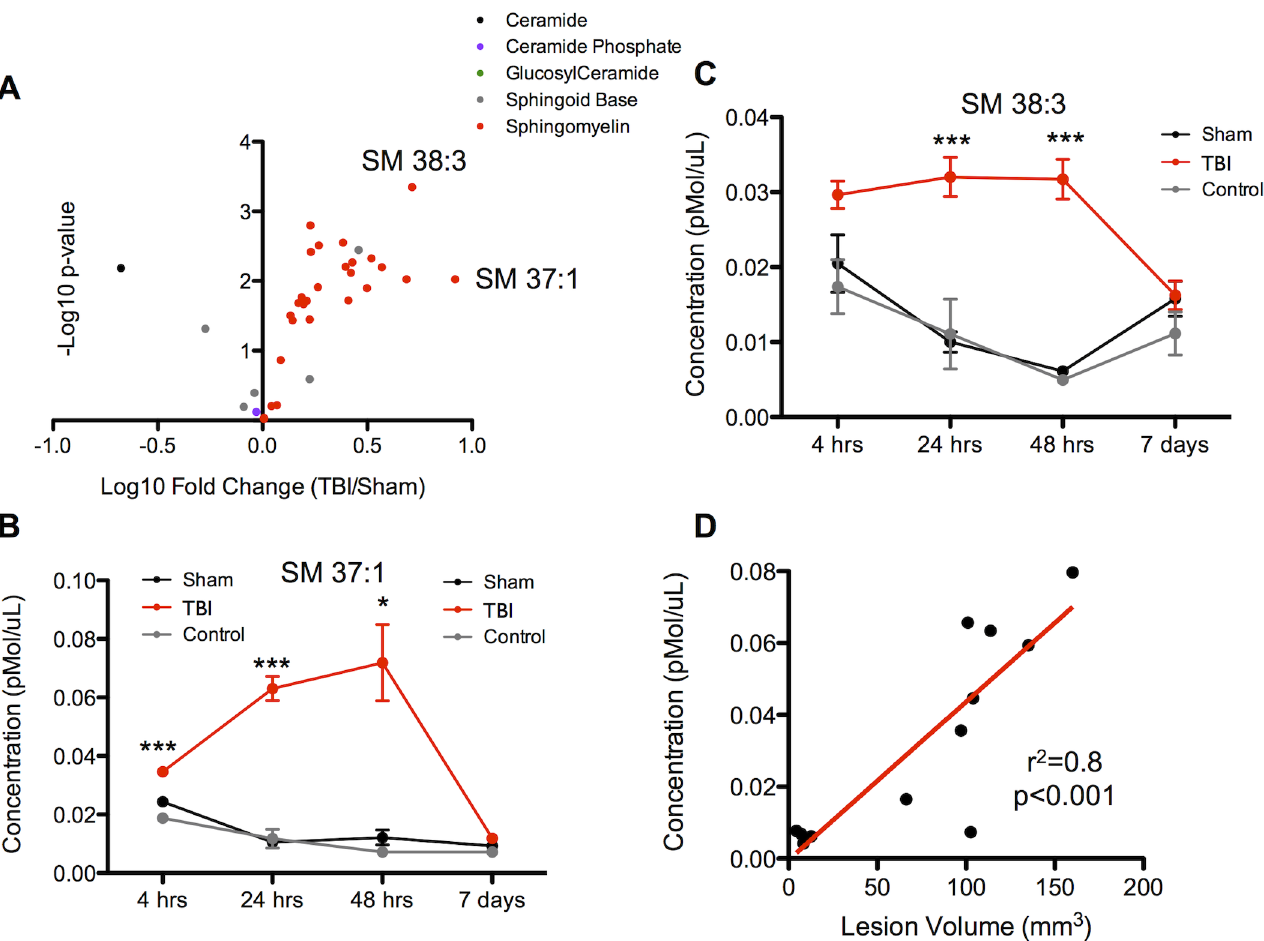
Fig 3. Sphingolipid profiling in controlled cortical impact in rats. (a) Volcano plot of the negative log 10 of the p-value (Student ’ s t-test, two-tailed) versus the log 10 of the normalized fold change in plasma concentration of TBI over sham animals at the 48 hour time point. Selected top performing sphingolipids are indicated by labels. n = 4 per sample. (b and c) Time course of the two sphingolipids with the greatest fold change. Red line indicates TBI animal, black line indicates sham animal, and grey line indicates control animal without any surgical procedure but with identical blood collection process. Data are shown as mean ± SEM. * indicates p < 0.05, *** indicates p < 0.001, Student ’ s t-test. n = 4 per sample. (d) Scatter plot demonstrating the relationship between the plasma concentration of the sphingolipid with the greatest fold change (SM 37:1) at 48 hours versus the volume of injured brain. Linear correlation shown in red (p < 0.001, Pearson ’ s correlation coefficient).